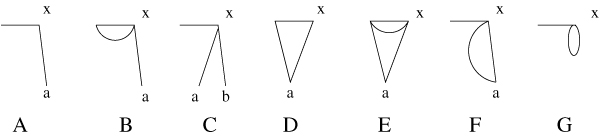
The remaining cases. The different configurations in which each vertex is adjacent to at most two desire edges, and no adjacencies can be created without creating a loop. In all cases, the picture shows a reality edge (horizontal line) and its adjacent desire edges (all other lines).